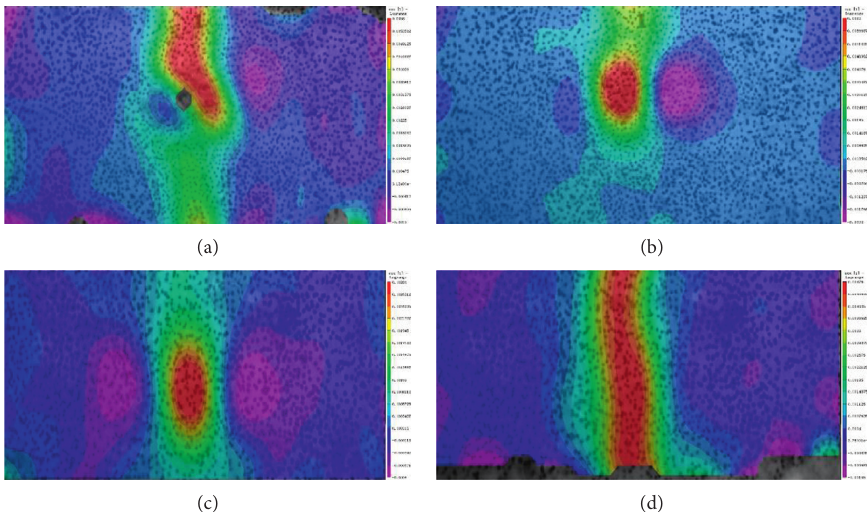
Figure 12: Strain cloud diagrams of failure process of engineered cementitious concrete